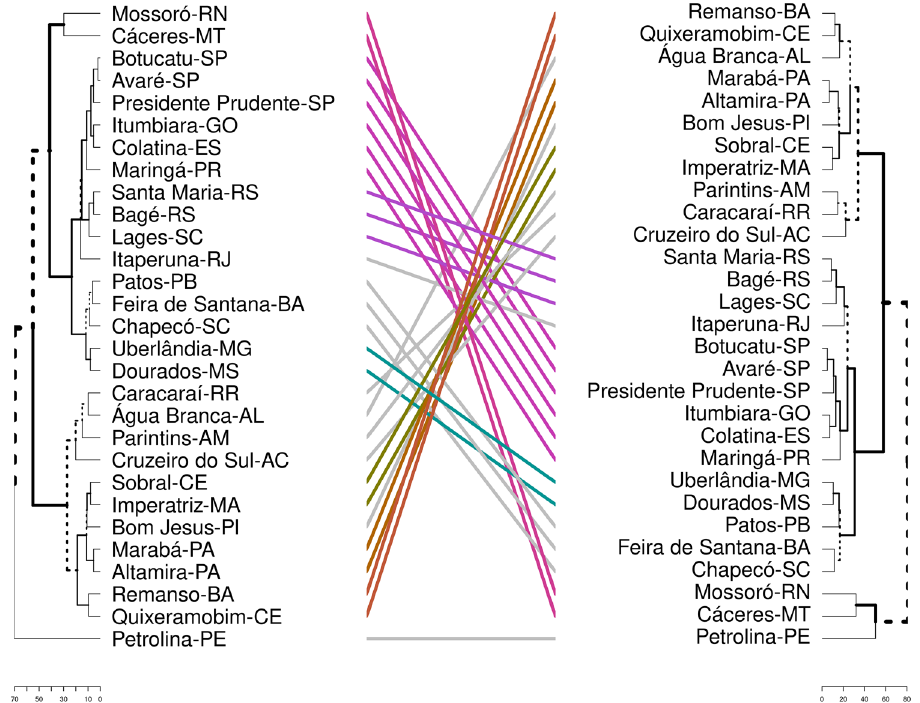
Figure 6. The municipalities are clustered in two ways, from left to right: (1) the proportion of fatal cases per age group and the age pyramid; (2) the same variables plus Human Development Index, population density, temperature, and humidity. The municipalities that changed group because of re-clustering are connected by gray line, while the ones that were kept together are connected through RGB color